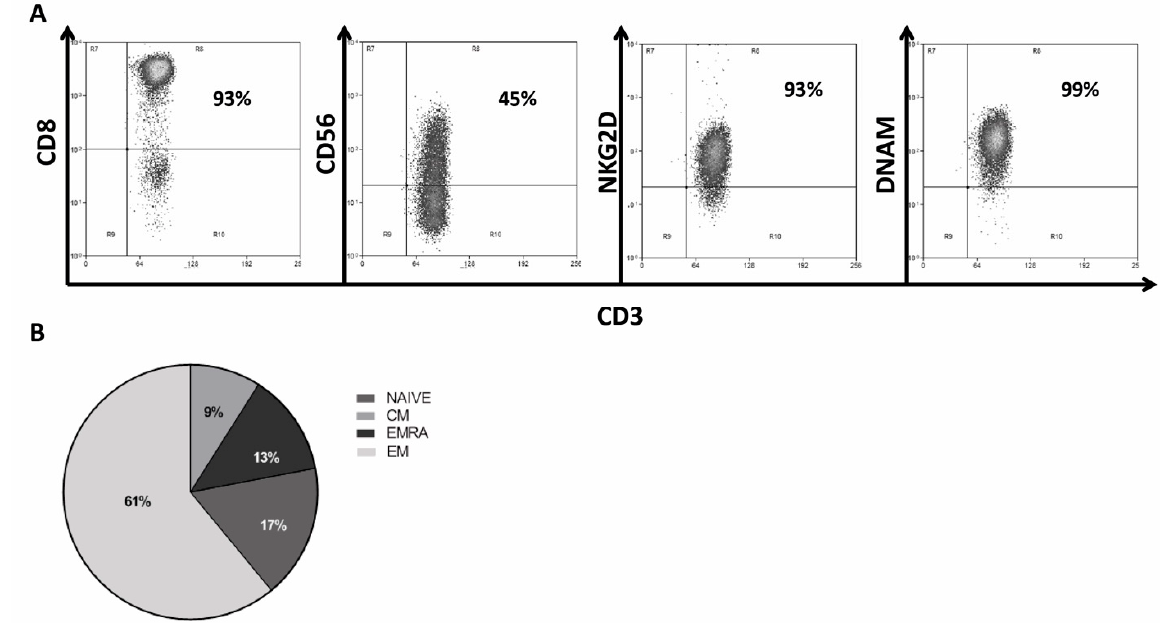
Figure 4. Phenotype and main subsets of patient-derived CIK lymphocytes. Representative pheno- type of CIK at the end of their ex vivo expansion; mature CIK were mainly CD3 + CD8 + with a relevant CD3 + CD56 + double-positive subset. The receptors mostly imputed to cancer cell recognition, NKG2D and DNAM-1, were expressed on a high percentage of cells ( A ). Distribution of main lym- phocyte subsets with effector memory (EM), effector memory-RA + (EM RA), central memory (CM), and naïve ( B